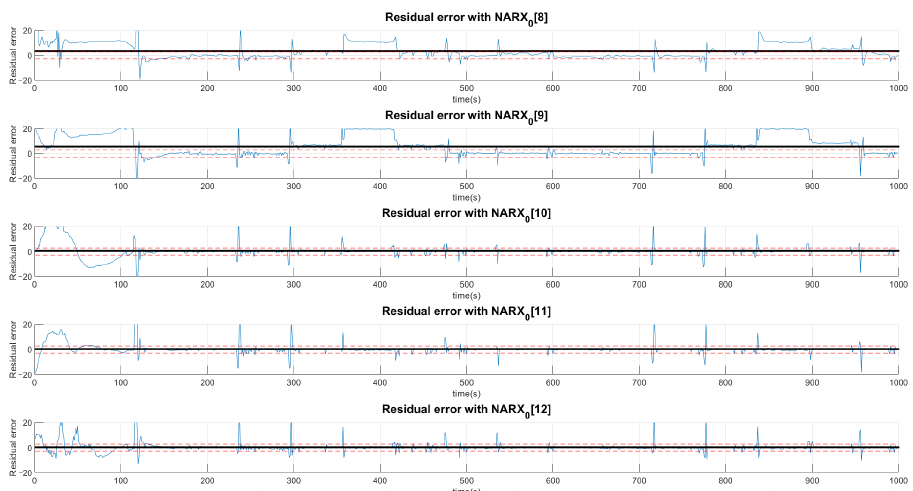
Figure 13. Production of plant residues when NARX networks expert to Faults F8, F9, F10, F11 and F12 are used. All of these are produced in the first layer (Layer 0) of the decision tree.